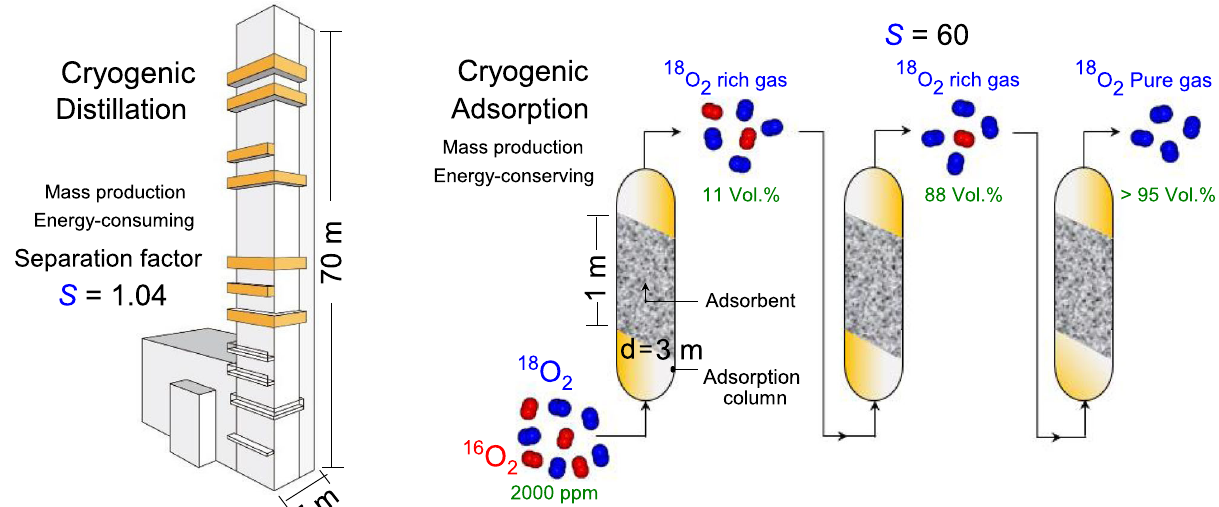
Fig. 1 Cryogenic distillation vs. Cryogenic adsorption-based selective separation of oxygen isotopes using carbide-derived carbon (CDC). The illustrative model quantitatively comparing the cryogenic distillation separation setup with the cryogenic adsorption-separation method. While distillation towers must be oriented vertically, adsorption beds can be con fi gured in many different orientations. The nanoporous adsorbent bed in the adsorption column preferentially adsorbs 18 O 2 according to the ratio determined by the adsorbent selectivity. The plausible adsorption-separation tower size was estimated for future consideration assuming the ideal conditions with the selectivity remaining at 60 and the adsorption capacity of 15mmol/g. The assumption of the adsorbent density of 500 kg/m 3 and space velocity = 10min − 1 leads to three separation towers with the capacity of 3 m (diameter) ×1 m (height) producing 18 O 2 of